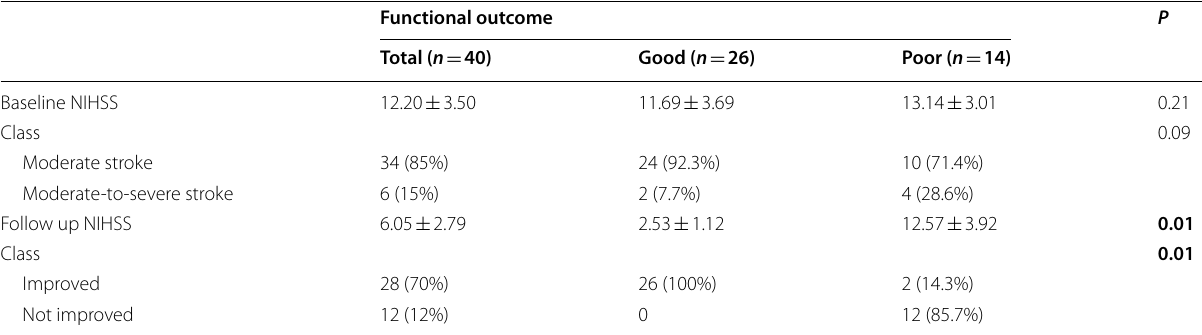
Table 2 National Institutes of Health Stroke Scale among studied patients